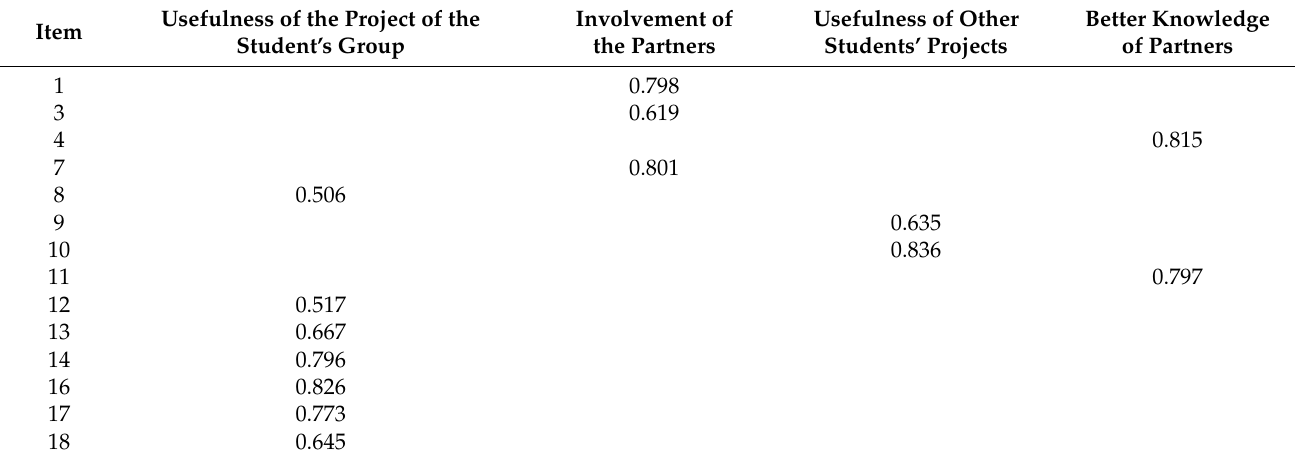
Table 4. Factor rotation matrix (a).